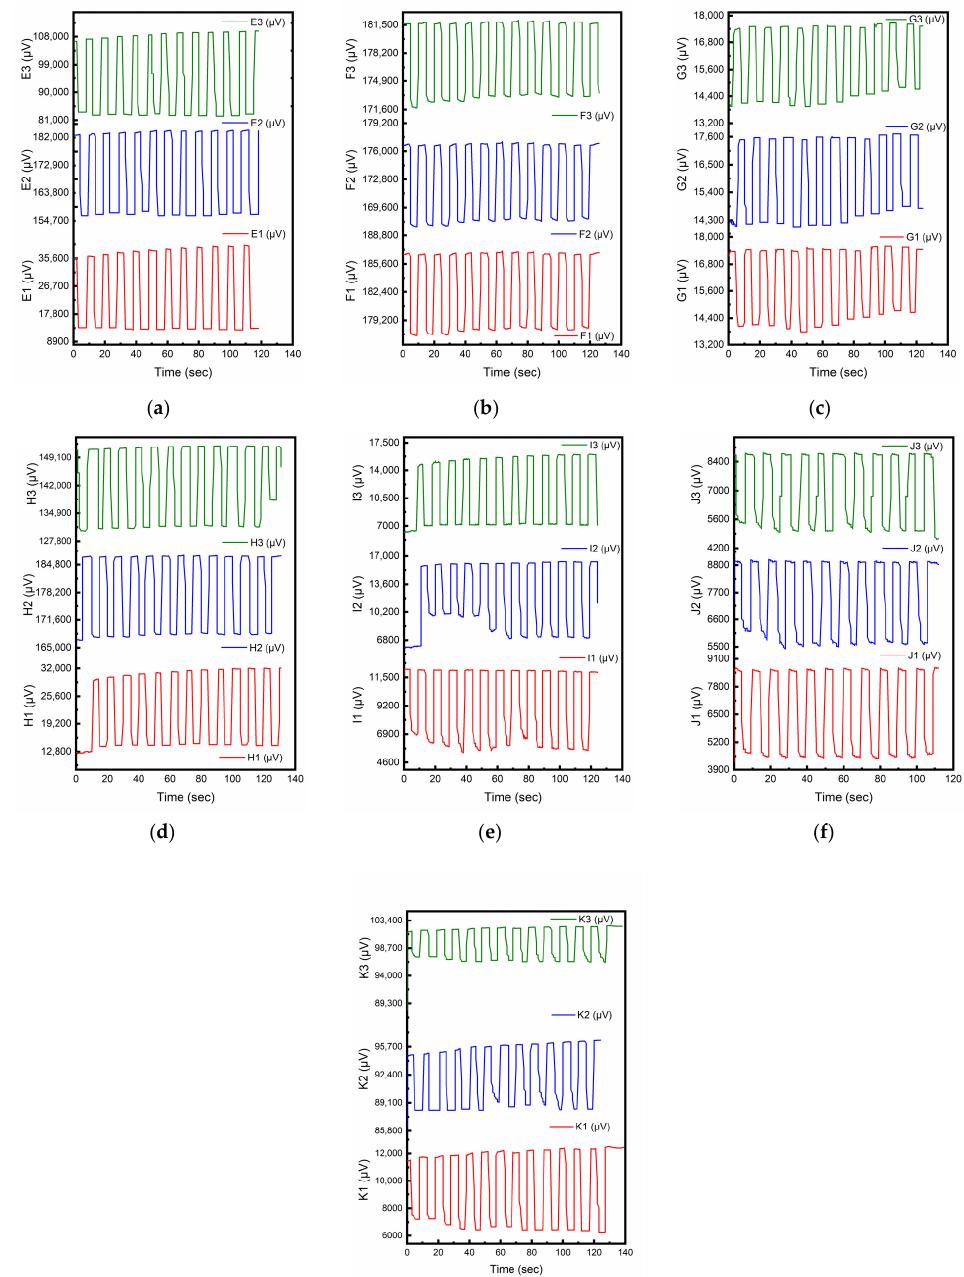
Figure 5. Piezoelectric responses for the CMC surface treatment method with different W/C ratios and concrete constituents. ( a ) W/C = 0.6 (Cement Only). ( b ) W/C = 0.5 (Cement Only). ( c ) W/C = 0.4 (Cement Only). ( d ) W/C = 0.6 (Cement: Sand= 1:2). ( e ) W/C = 0.5 (Cement: Sand= 1:2). ( f ) W/C = 0.4 (Cement:Sand = 1:2). ( g ) W/C =0.6 (Cement:Sand:Aggregate = 1:2:3).